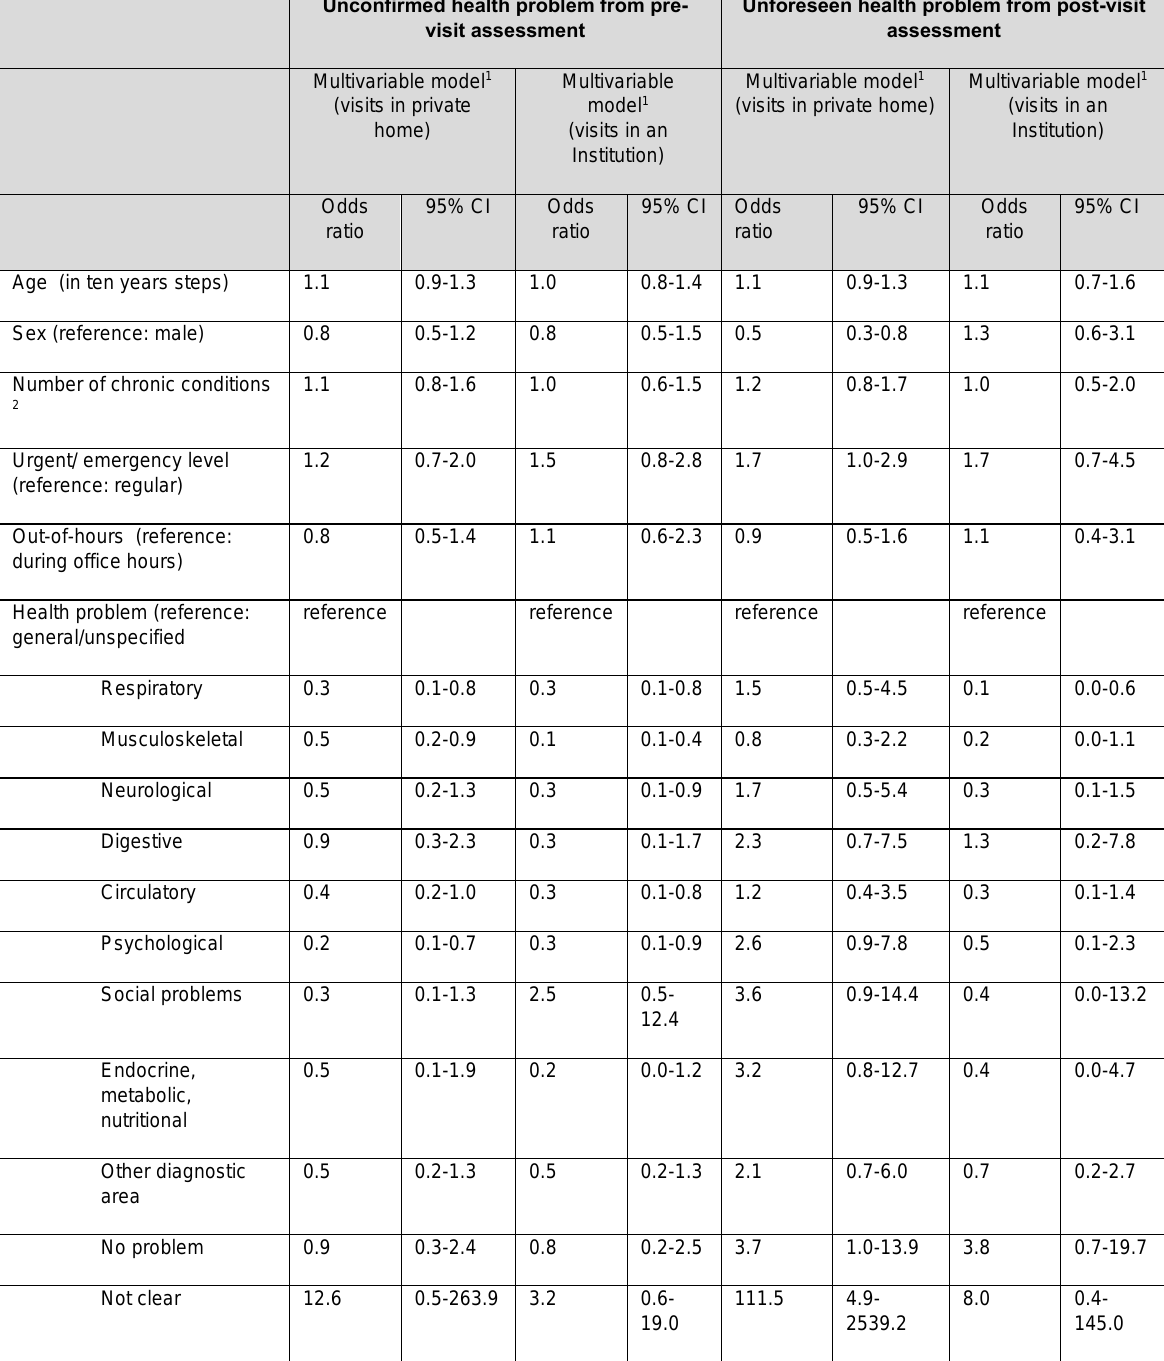
Table S 3 : A ssociations of possible red flags w ith unconfirmed and unforeseen health problems, stratified by place of home visit Unconfirmed health problem from pre- Unforeseen health problem from post-visit visit assessment assessment Multivariable model 1 (visits in private